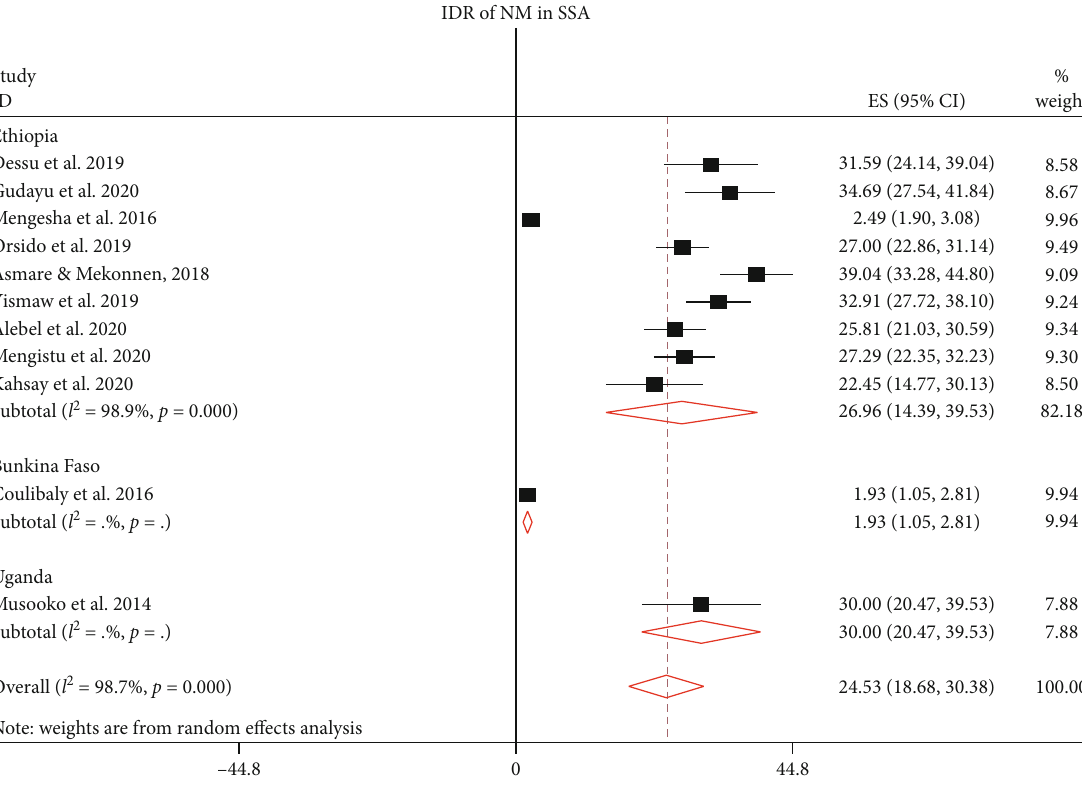
Figure 4: The IDR of neonatal mortality among neonates treated in the NICUs of SSA.